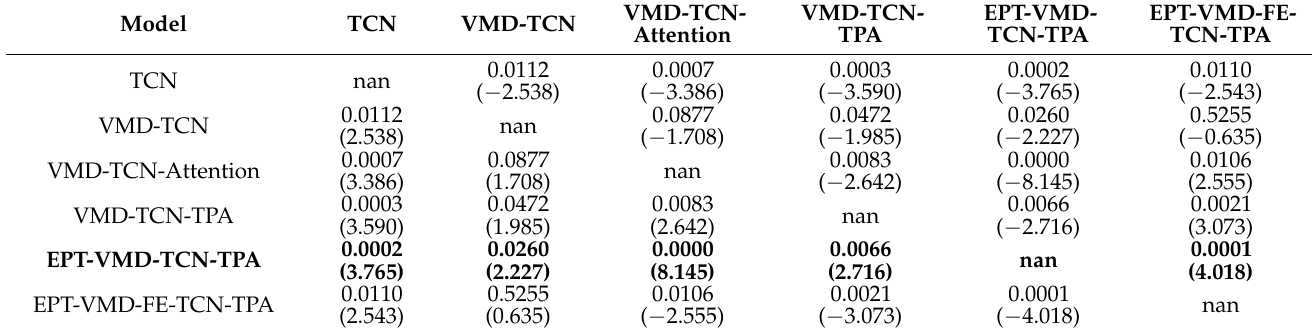
Figure 18. ACF and PACF plots of TCN ( a , b ), VMD-TCN ( c , d ), VMD-TCN-Attention ( e , f ), VMD- Table 9. DM test value